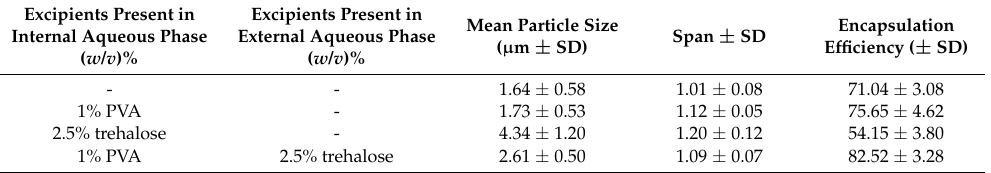
Table 4. Effect of excipients in internal aqueous phase and external aqueous phase on particle size, span value and encapsulation efficiency for lysozyme loaded double-walled